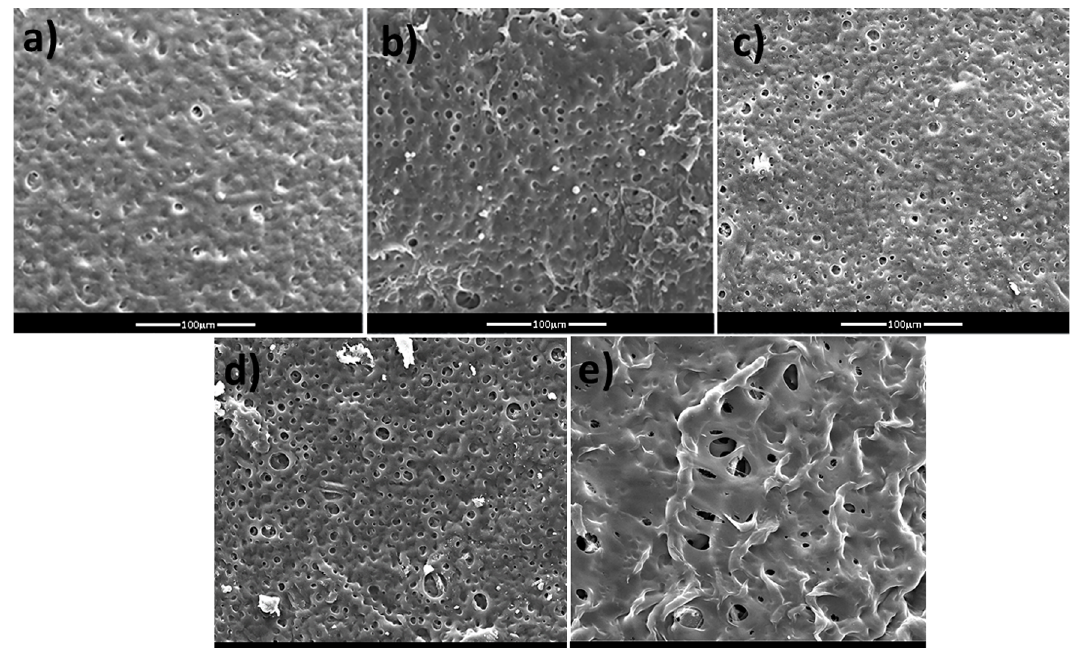
Figure 6. Micrographs obtained for PU and PU composites. (a)PU, (b) PU/CELLULOSE 10%, (c) PU/CPIL-TBP 10%, (d) PU/CPIL-TBP 20% and (d) PU/CPIL-TBP